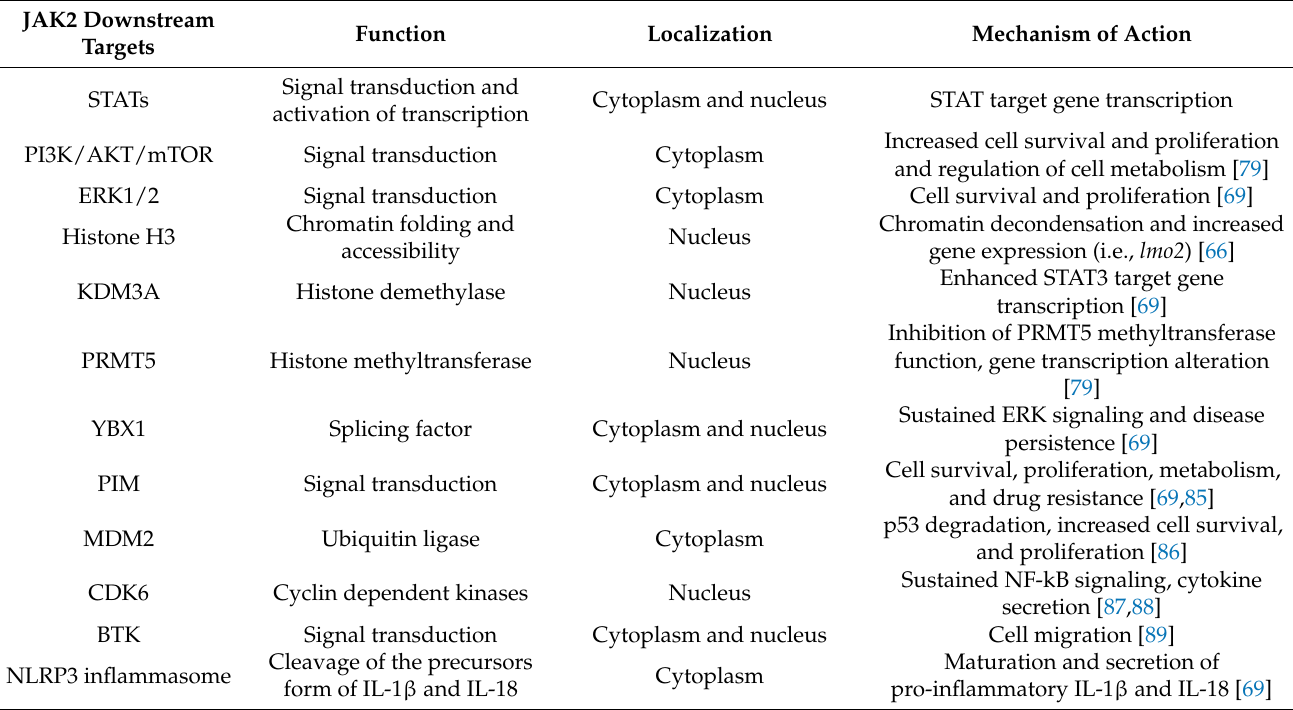
Table 3. Direct and indirect JAK2 downstream targets involved in JAK2 inhibitor resistance and disease